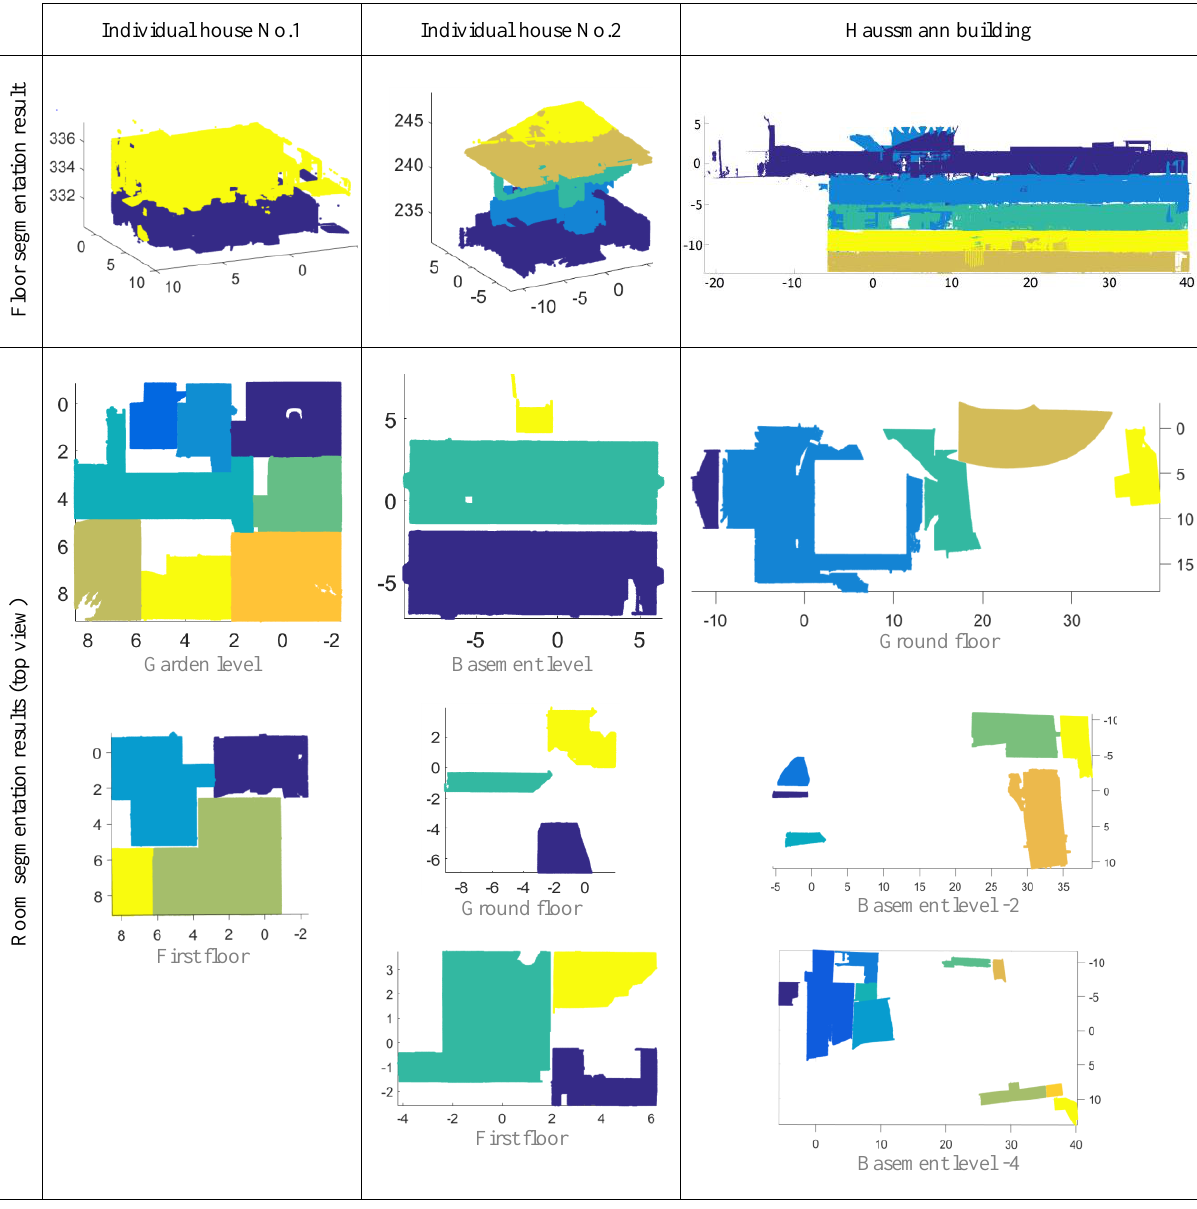
Table 8. Results of floor and room segmentation for the three different